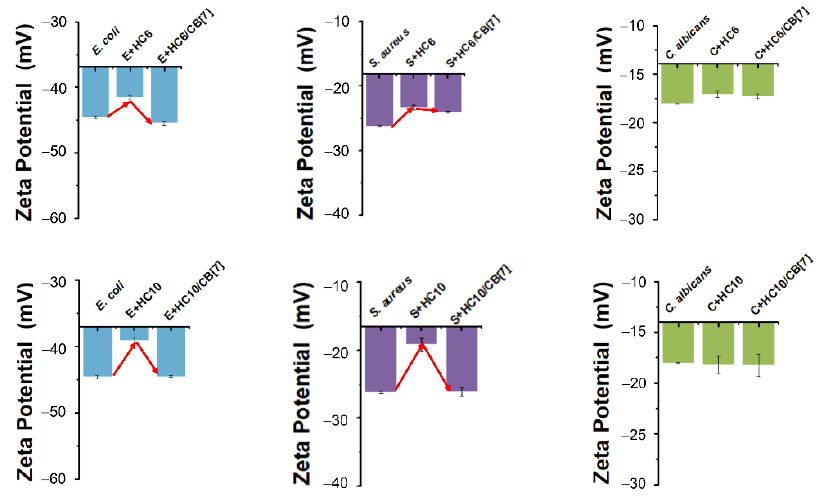
Figure 3. Diagram of zeta potentials of E. coli , S. aureus and C. albicans before and after binding with HC6, HC10 and their supramolecular assemblies (HC6/HC10:CB[7] = 1:10), where E = E. coli , S = S. aureus , C = C. albicans .